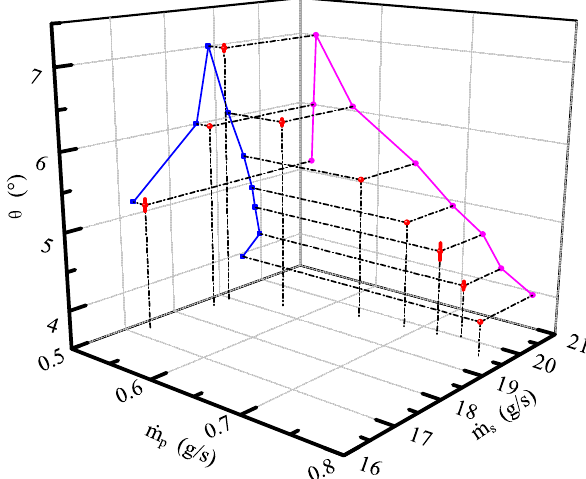
Figure 10. Relationship between the spray half cone-angle and primary and secondary flow mass flow rate.